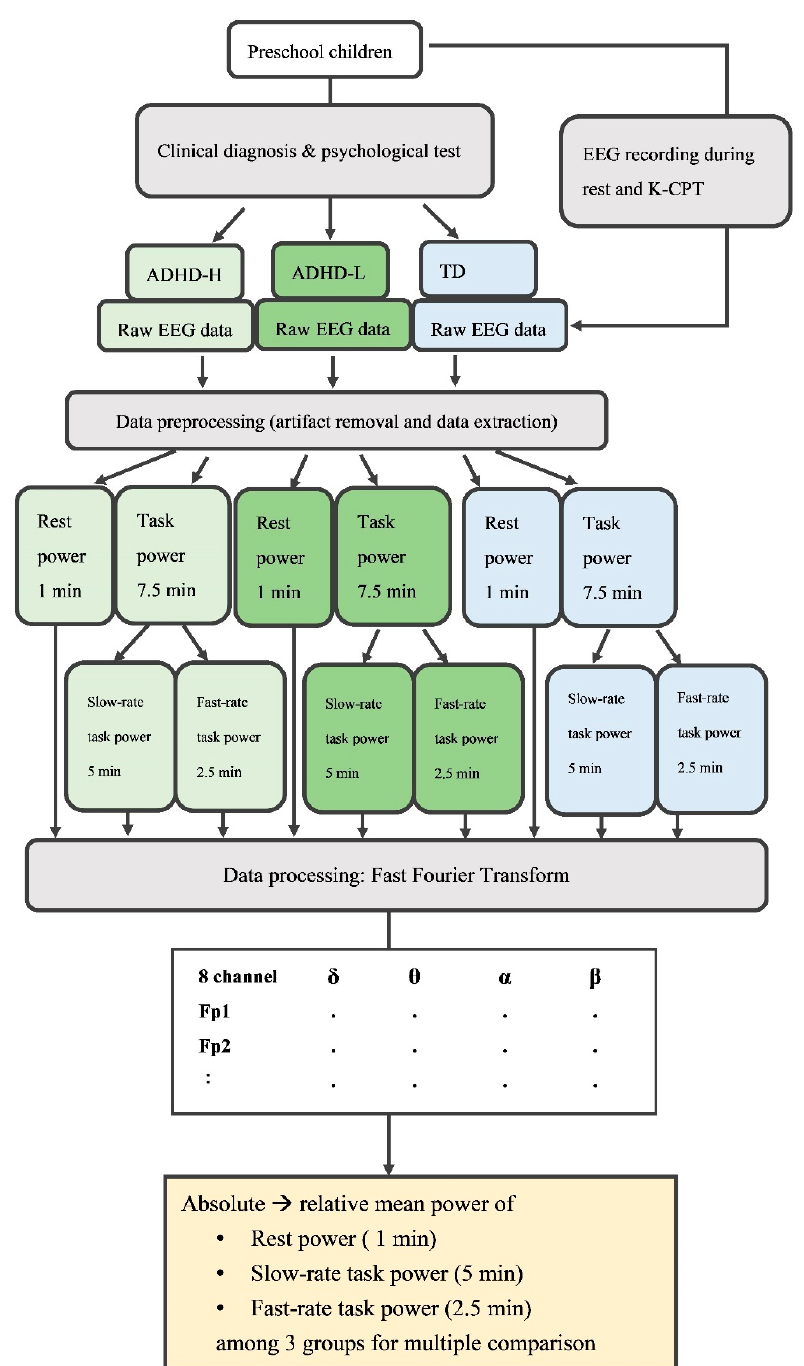
Figure 1. The framework of the